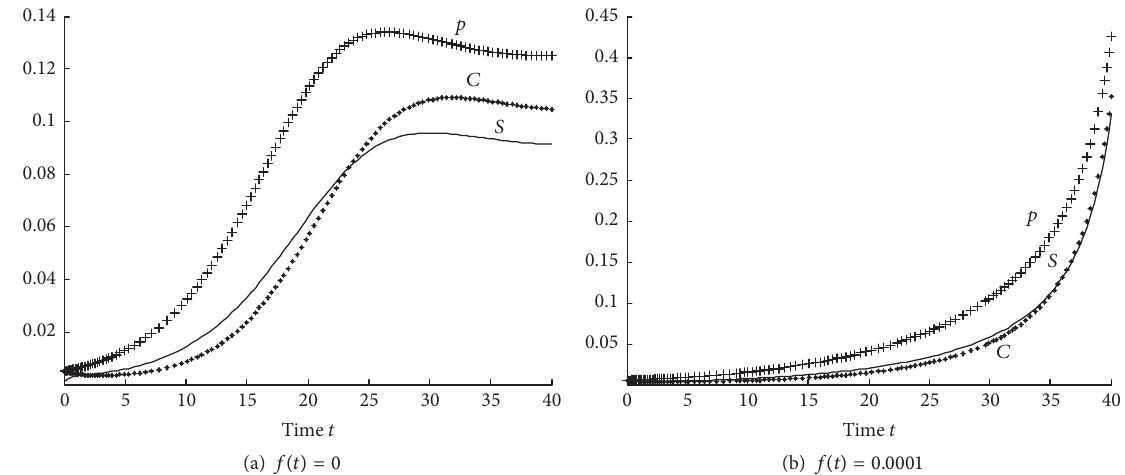
Figure 3: Variation trends of parameters and resource elements under system instability (when 𝑟 > 𝜃 1 ).